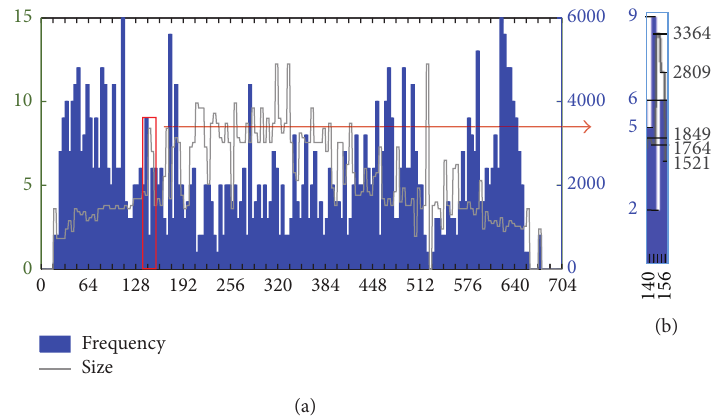
Figure 13: (a) MIN SIZE threshold figure. (b) Detail with enlarged scale of (a).